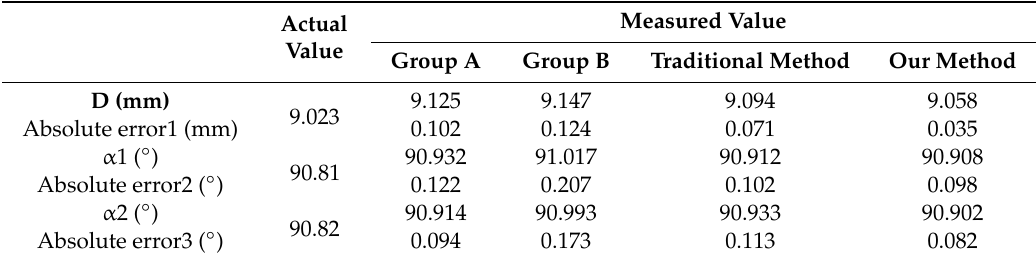
Table 1. Summary of measurement results (the averaged of multiple measurements).